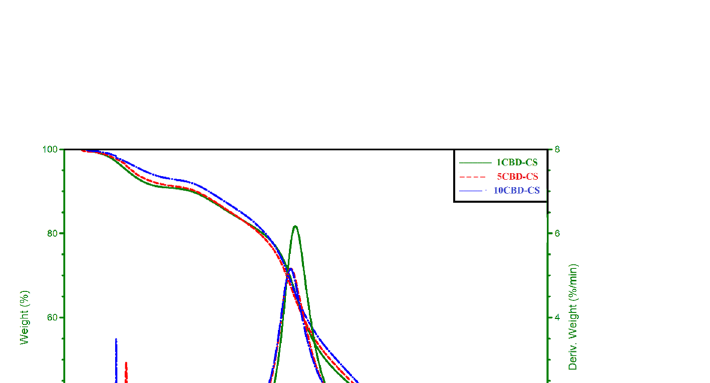
Figure 2. SEM images of ( a ) chitosan, ( b ) 1CBD-CS, ( c ) 5CBD-CS, and ( d ) 10CBD-CS films; cannabidiol- chitosan-based films (CBD-CS), where 1, 5, 10CBD-CS corresponds to the weight ratio of 1, 5 or 10% of cannabidiol oil (CBD) to chitosan (CS).